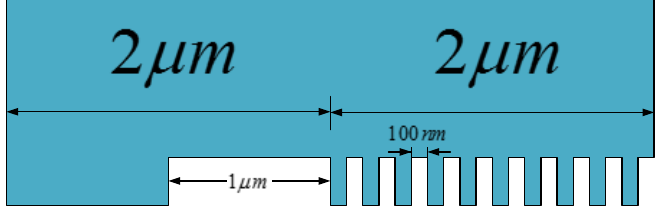
Figure 3. Feature units with a micro/nano ratio of 1:1.